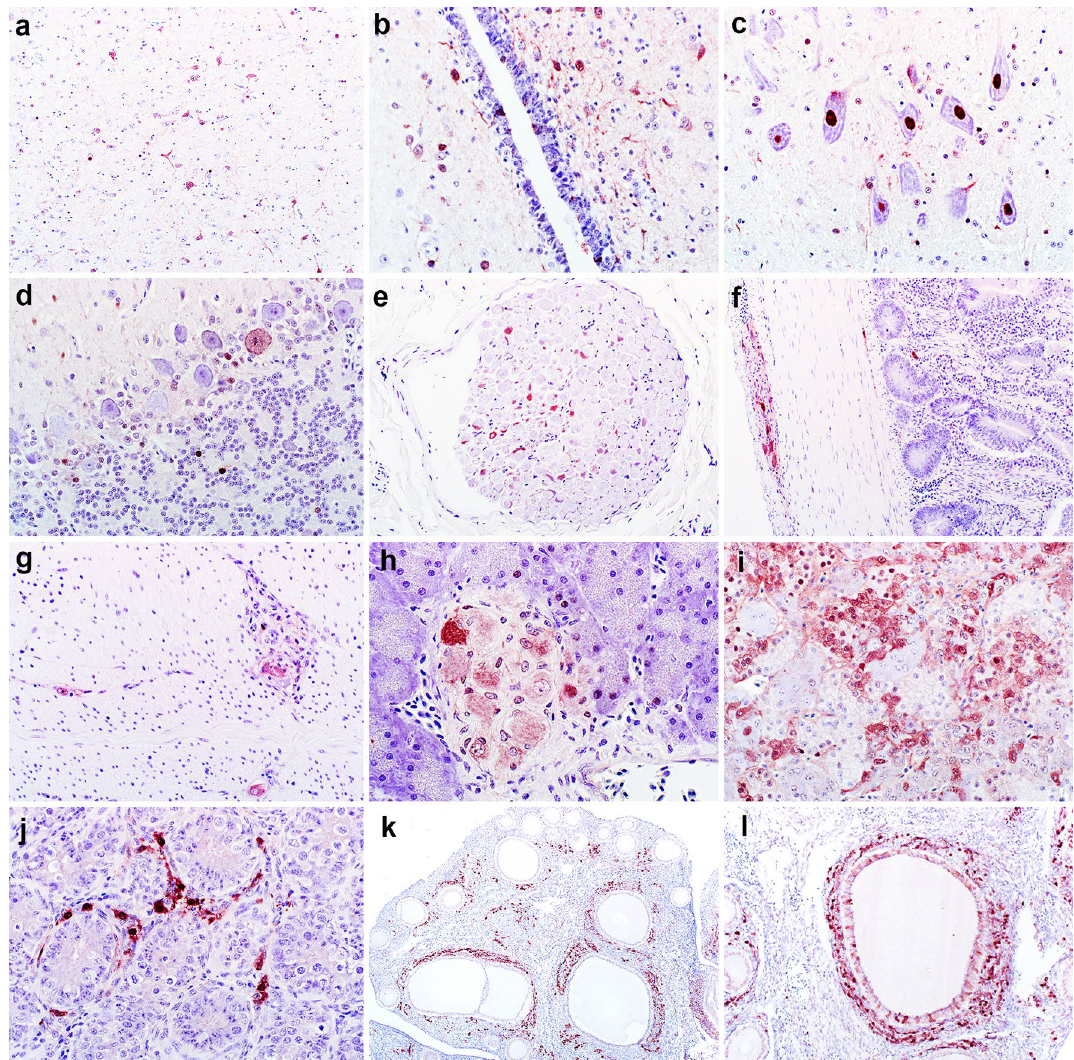
Figure 5. Representative immunohistochemical (IHC) reactivity for ABBV-1 nucleoprotein (N) in tissues of Muscovy ducks experimentally infected intracranially with ABBV-1 and sampled at 12 weeks post infection (wpi). ( a–d ) Immunoreactivity for ABBV-1N is observed in scattered neurons and glial cells in the cortex of the forebrain ( a , duck #502), periventricular neuroparenchyma and rare ependymal cells ( b , duck #537), in clusters of large neurons in the medulla oblongata ( c , duck #543), and in scattered Purkinje and granular cell in the cerebellum ( d , duck #502). Reactivity is most often intensely nuclear, with rare light cytoplasmic signal. ( e–l ) In the peripheral nervous tissue, immunoreactivity is observed in the axons of peripheral nerves ( e , duck #502), myenteric plexuses of the small intestine ( f , duck #542), and ventriculus ( g , duck #502), ganglia and acinar cells of the pancreas ( h , duck #502), and medullary and cortical cells of the adrenal gland ( i , duck #502). ( j–l ) In the testis, reactivity is observed in the interstitial cells between tubules ( j , duck #502), and in the ovary, reactivity is present in the interstitial cells between follicles, theca cells, and granulosa cells ( k–l , duck Virus isolation from brains and kidneys. Viable brains from all birds in the IC and IM groups at 12 wpi were used for virus isolation. In the IC and IM groups, respectively, 8/11 and 8/8 brains yielded ABBV-1 in CCl- 141 cells after up to four passages, as shown by nuclear and weak cytoplasmic signal in scattered cells by IFA. Although 12 birds were in the IC group, one brain could not be tested due to poor sample preservation. Similarly, the kidneys from 2 ducks in the IC group at 12 wpi, which tested positive for RT-qPCR but were negative by IHC, yielded ABBV-1 in CCl-141 cells after three passages (Supplementary Figure S4). The control brains (n = 4) and kidney (n = 1) from the CO group at 12 wpi yielded no virus.